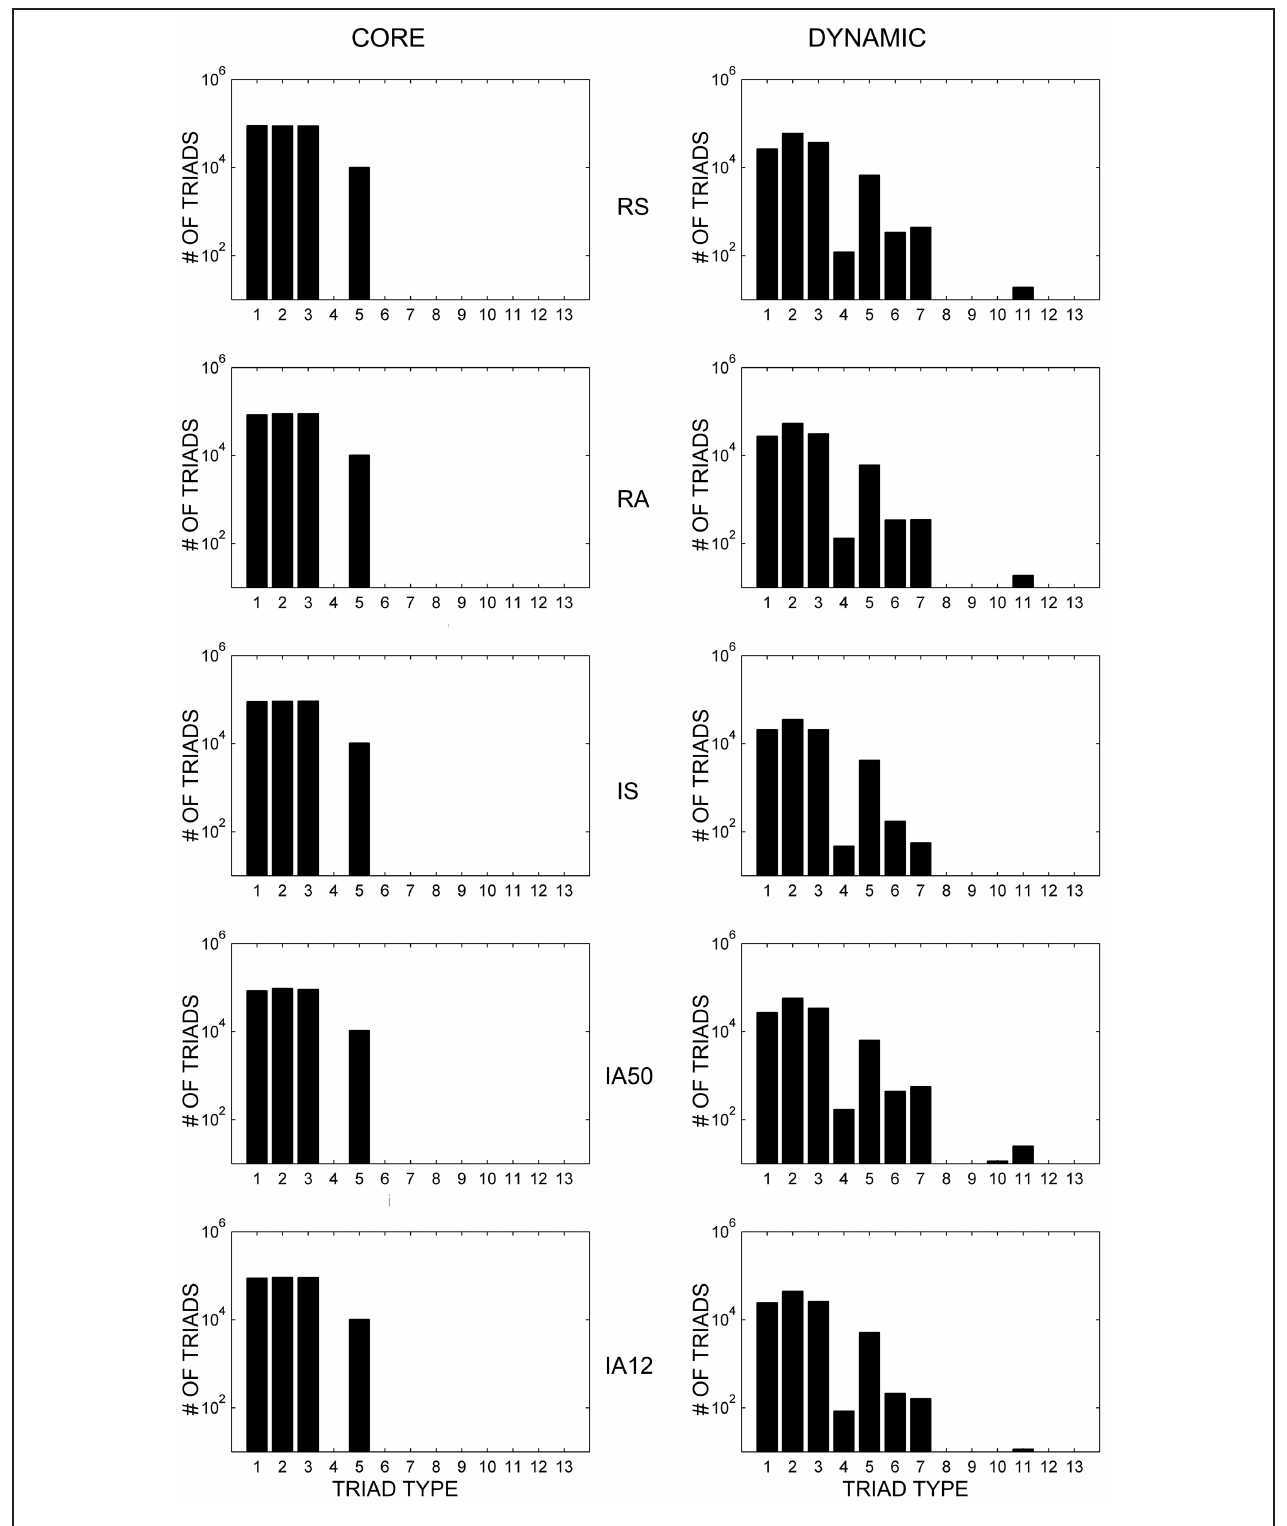
FIGURE 5 | Core and dynamic triad type distributions. Triad type distributions for core (left) and dynamic (right) triads in response to each external input regime averaged across 10 simulations. Dynamic triad distributions are averaged across the analysis interval for each